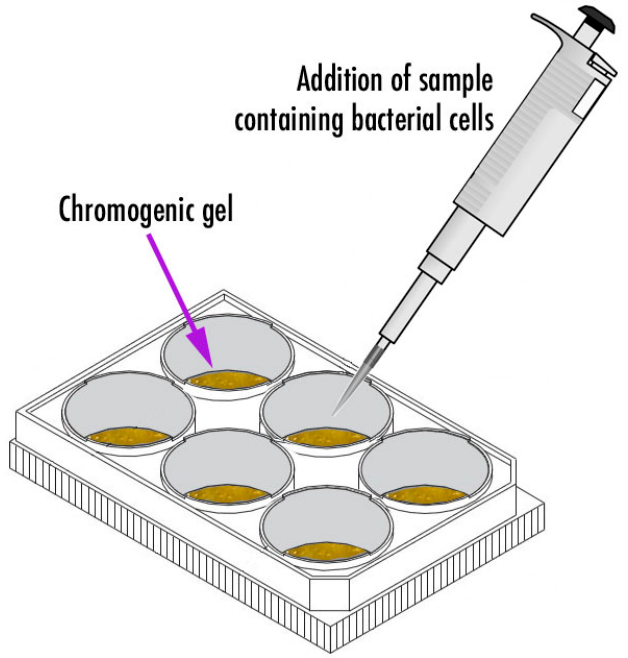
Figure 1. Bio-detection system I, consisting of a six-well culture plate within which the chromogenic formulations integrating a cocktail of phage particles and sodium 1,2-naftoquinone-4-sulfonate together with specific amounts of gelatin and casein were poured and allowed to polymerize.